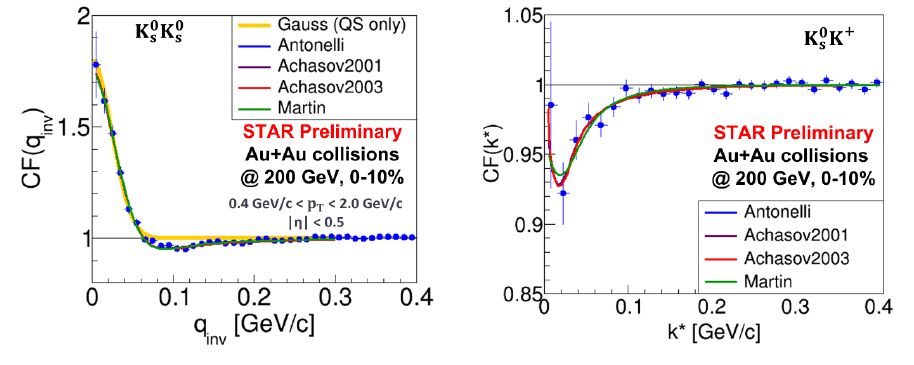
√ s NN = 200 GeV for neutral kaons (left) and